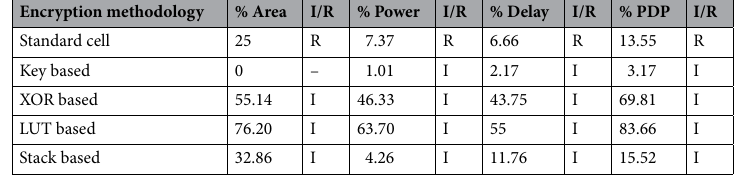
Table 18. % of Changes for OR gate.